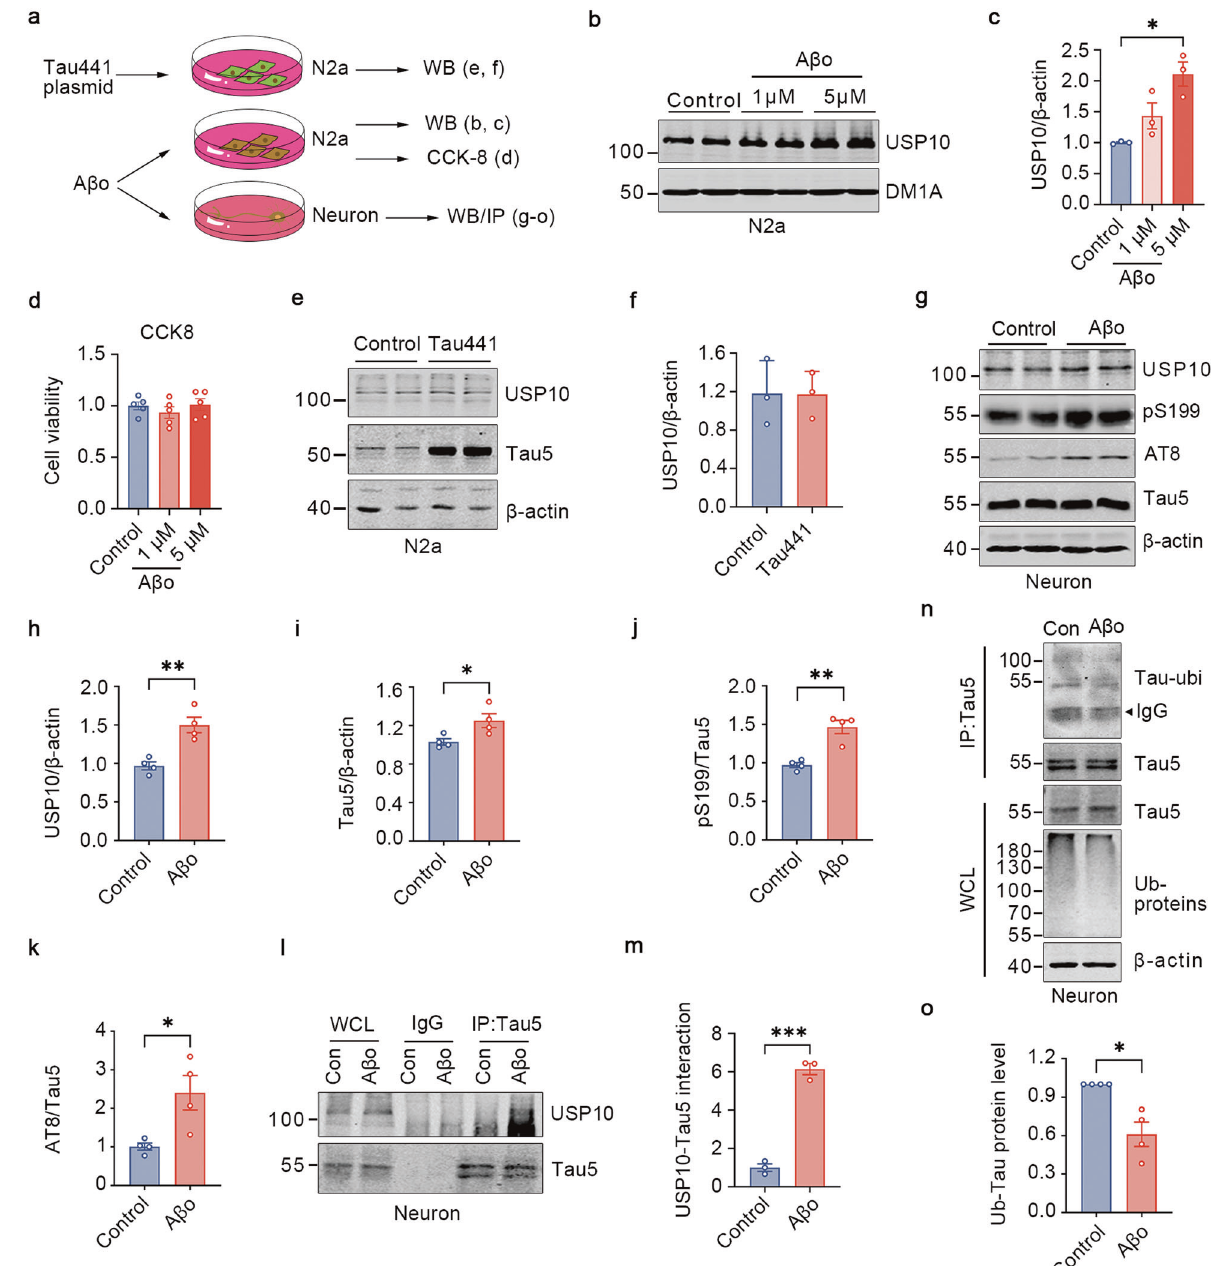
Fig. 2 A β o triggers USP10 upregulation inducing deubiquitination and hyperphosphorylation of Tau. a A Schematics of the experimental design. b Concentrations of 1 μ M and 5 μ M of A β 42 oligomers(A β o) were used after overnight incubation at 4 °C to treat N2a cells. c Quanti fi cation of WB bands showed that USP10 expression was increased by A β o treatment; n = 3 independent experiments. d CCK-8 was used to detect the cell viability of N2a as indicated; n = 5 independent experiment. e , f Overexpression of the Tau441 plasmid did not affect the USP10 expression. n = 3 independent experiments g . Rat primary hippocampus neurons were grown until day 7, western blotting analyses for the level of USP10, Tau5, AT8, and pS199 under control conditions and 24 h after 2 μ M A β 42 oligomers treatment. h – k . Graphs showing the normalized protein levels of USP10, pS199, AT8(Ser202/Thr205), and Tau5; n = 4 independent experiments. l A β o promotes the interaction of USP10 with Tau5. Rat primary neurons lysates were subjected to immunoprecipitation with control IgG, anti-Tau5 antibodies. m Graph showing the normalized level of USP10-Tau interaction. IP samples and whole-cell lysates (WCL) were analyzed using western blotting; n = 3 independent experiments. n , o A β o triggered a decrease in Tau5 ubiquitination. Neuron lysates were incubated with protein A + G magnetic beads and lysates were immunoblotted as indicated; n = 4 independent experiments. All data represent mean ± SEM, p -value signi fi cance is calculated from a two-tailed t-test. * P < 0.05, ** P <